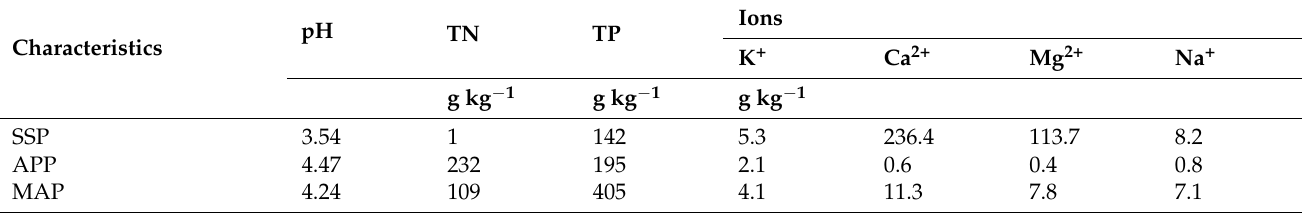
Table 2. Chemical properties of different P